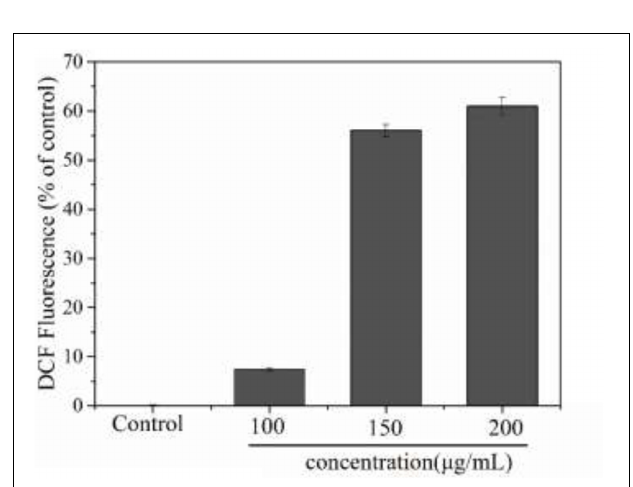
FIGURE 9 | Changes of intracellular ROS level of MCF-7 cells induced by PNHE. Values presented are means ± SD of